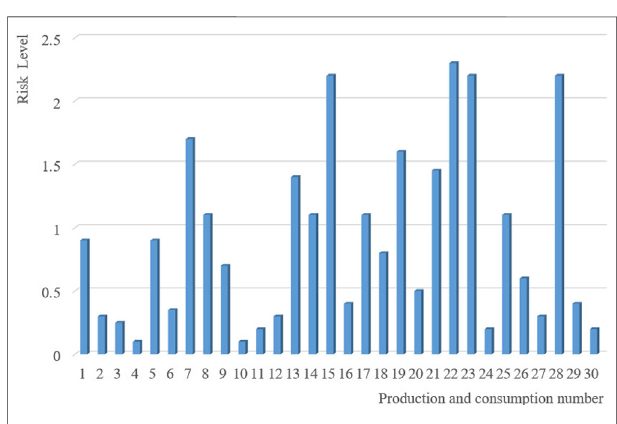
FIGURE 3 | Fault risk classi fi cation chart.